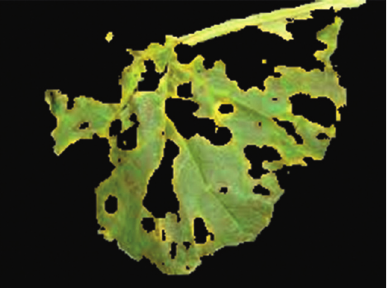
Figure 10: Objects in cluster 2.